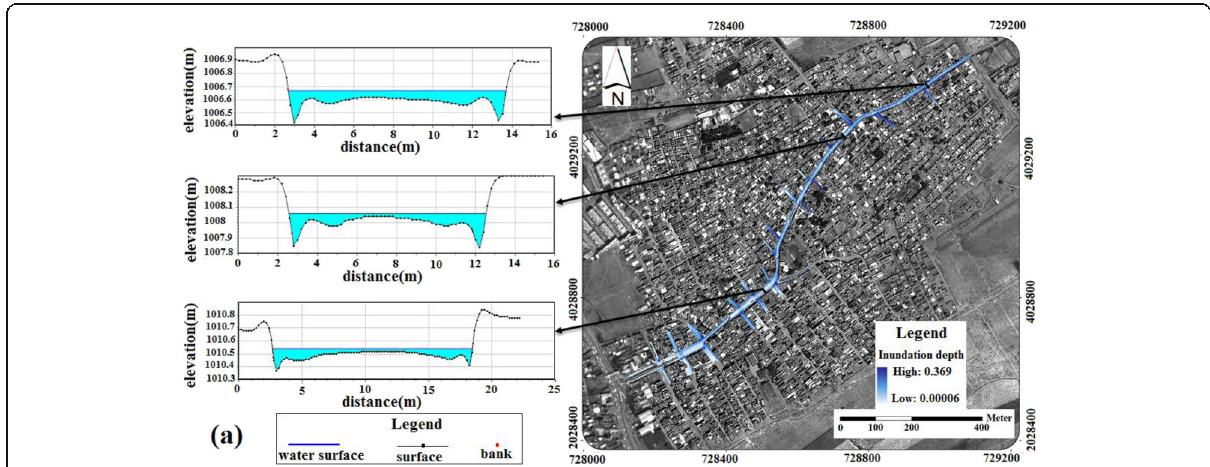
Fig. 8 Inundation zone map and water depth at cross sections profiles in 5 year return period